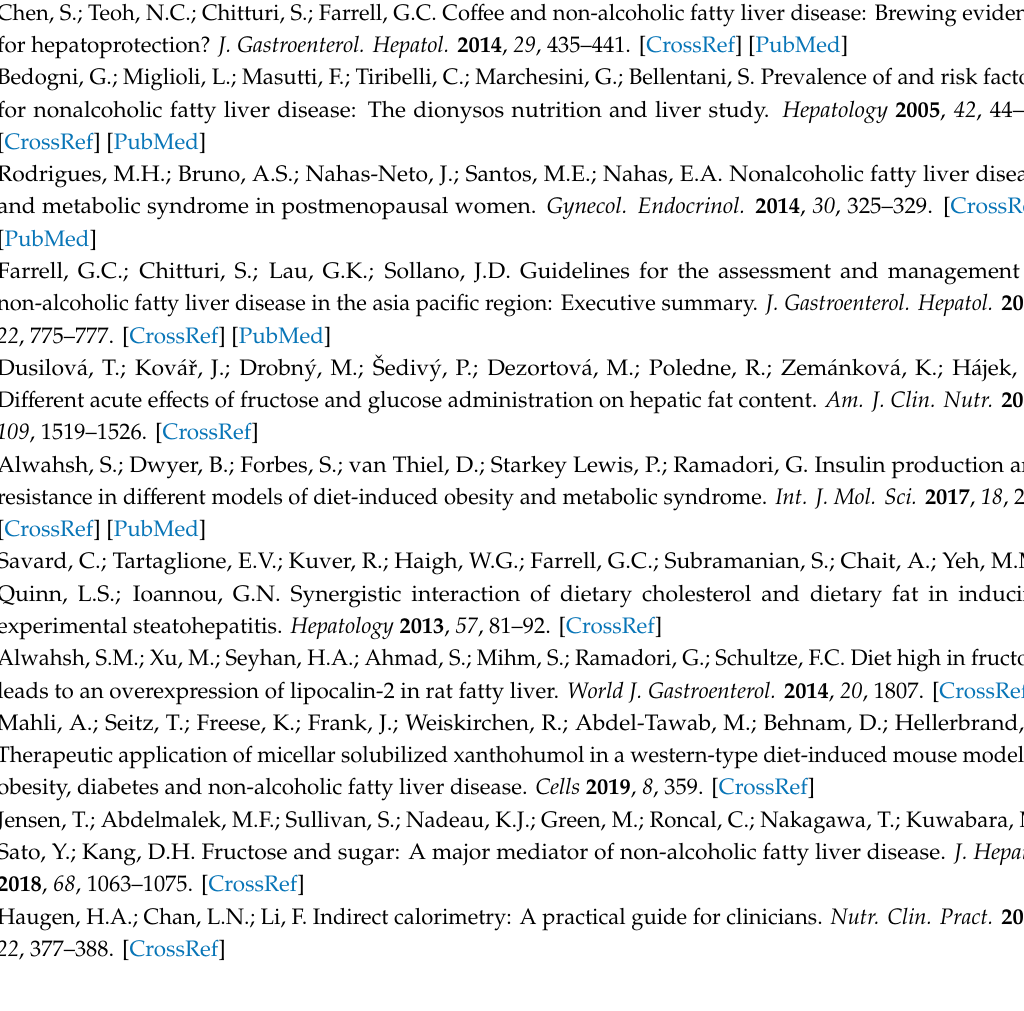
Table S1: Grading used for liver